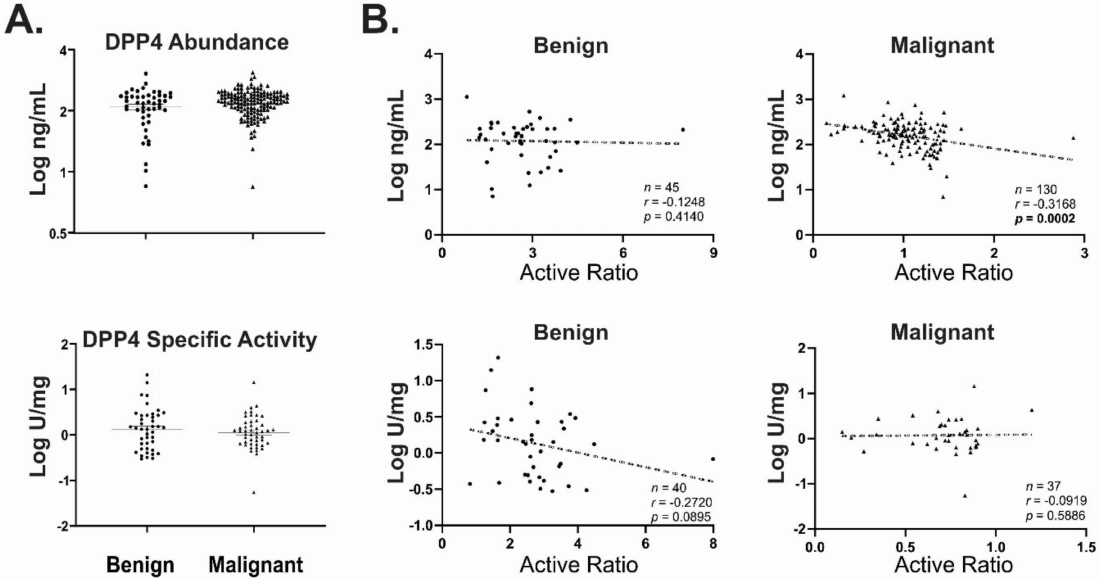
Figure 6. DPP4 abundance and specific activity in clinical samples. ( A ) DPP4 abundance (benign n = 49; malignant n = 148) and specific activity (benign n = 49; malignant n = 50) in patient’s ascites fluid were measured by ELISA or activity assay, respectively. ( B ) Correlations between active ratio and DPP4 abundance (upper panel) or specific activity (lower panel) in matching ascites